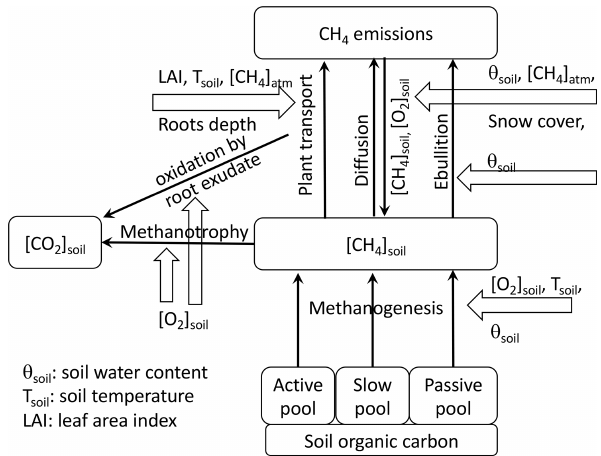
Figure 1. Model diagram of methane cycling processes in ORCHIDEE-PCH 4 . Carbon fluxes are indicated by thin black ar- rows. Other variables that influence each carbon flux are displayed on white